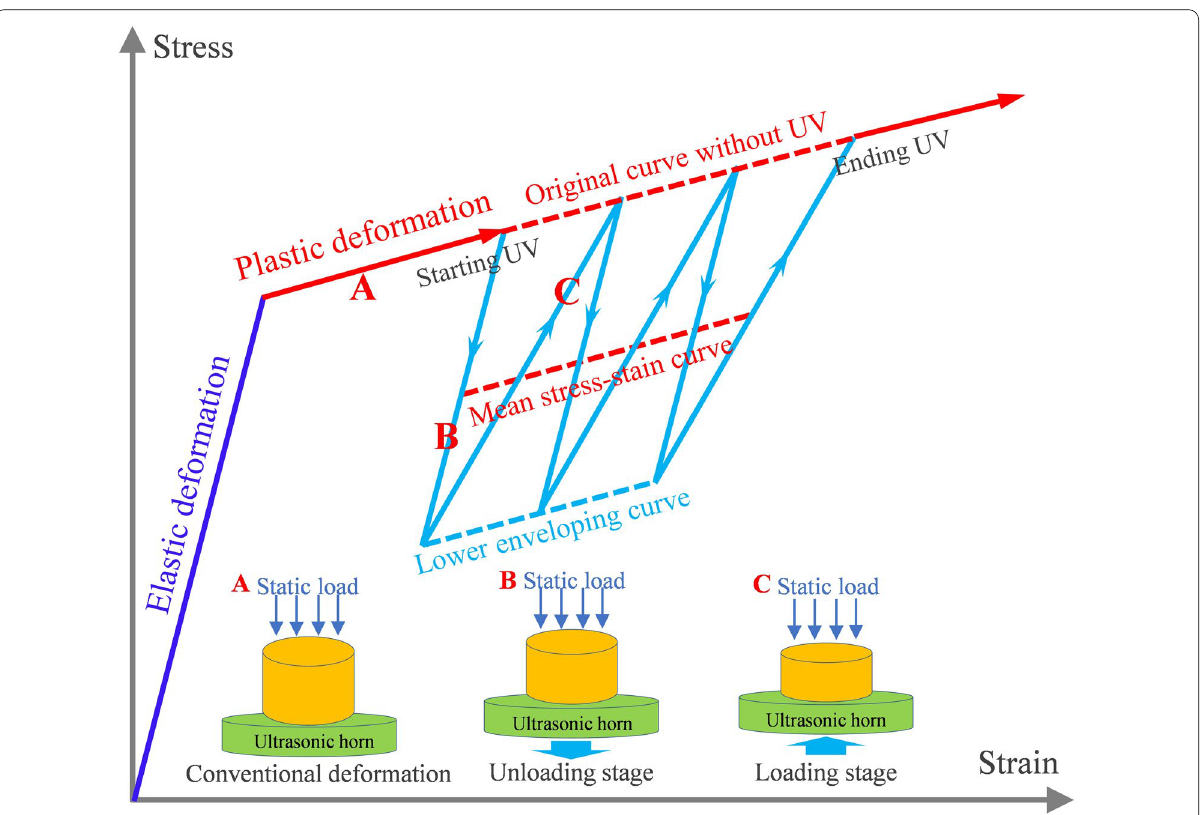
Figure 2 Schematic diagram of stress superposition